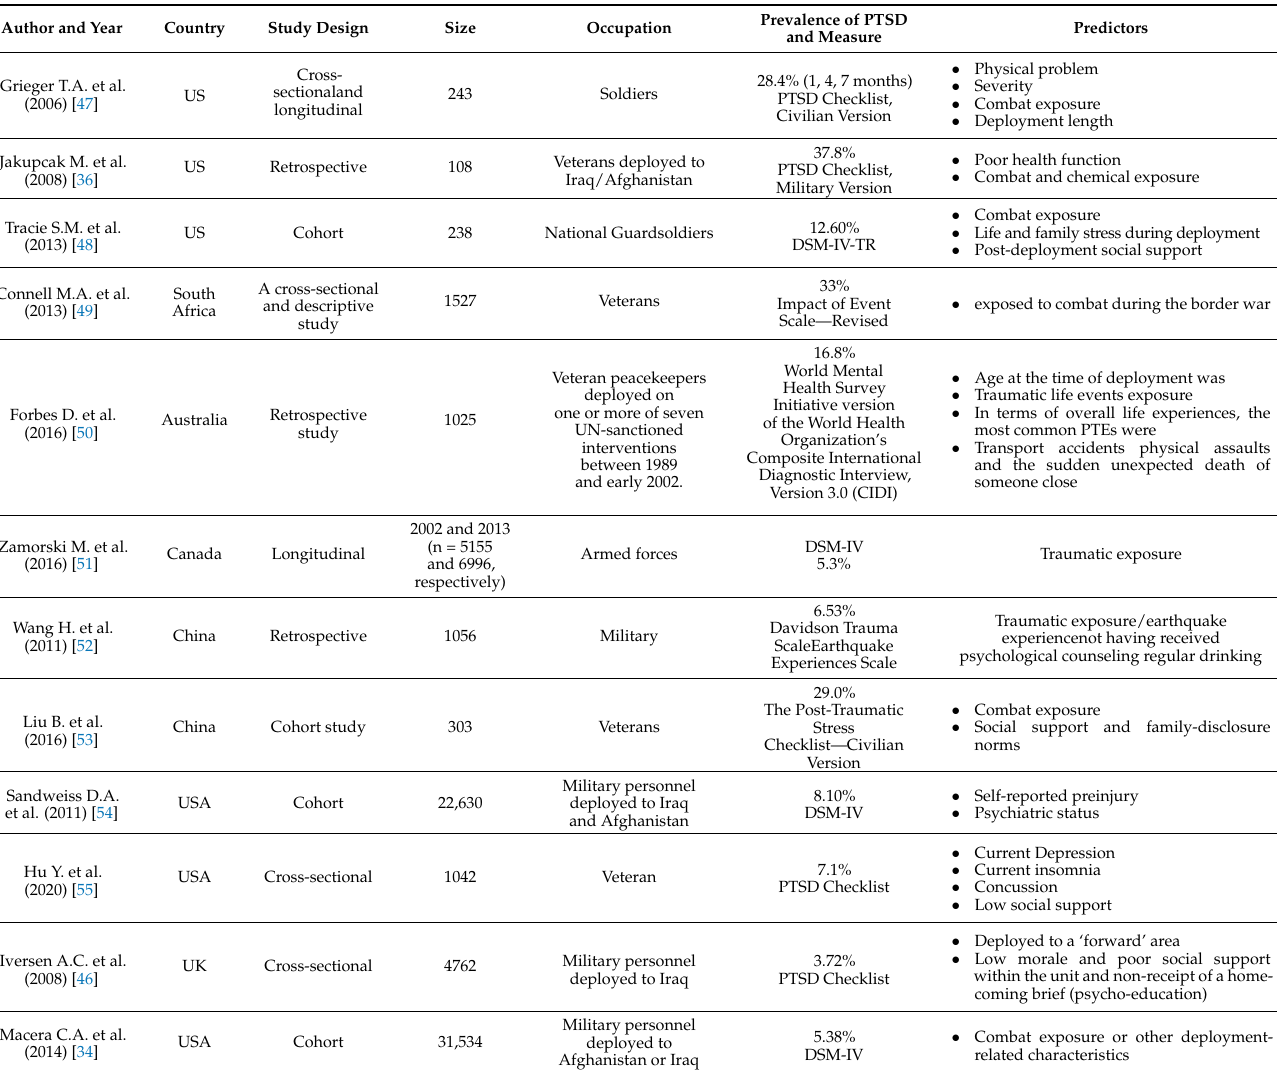
Table 1. Summary of studies with prevalence and predictors of PTSD among Military